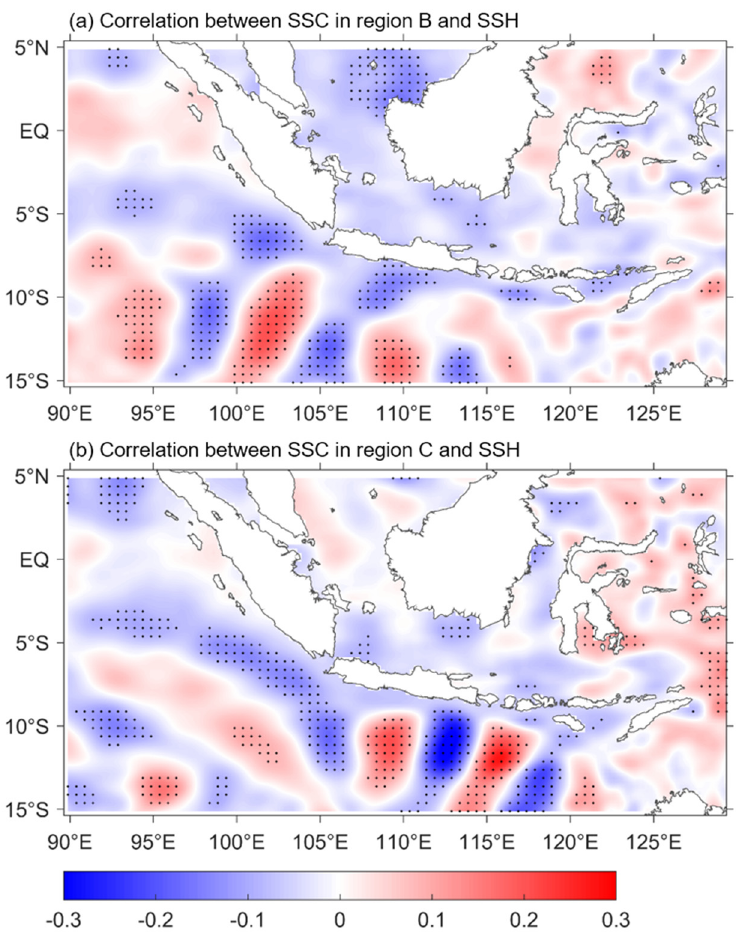
Figure 8. ( a ) Correlations between the area averaged intraseasonal SSC south of the Sunda Strait (Region B in Figure 3a) and intraseasonal SSH; ( b ) same as (a) but for the area averaged intraseasonal SSC south of Lombok Strait (Region C in Figure 3a). The intraseasonal time series are extracted from raw data during the period of 1 January 1998 to 31 December 2019 by employing a 20–90-days bandpass filter.